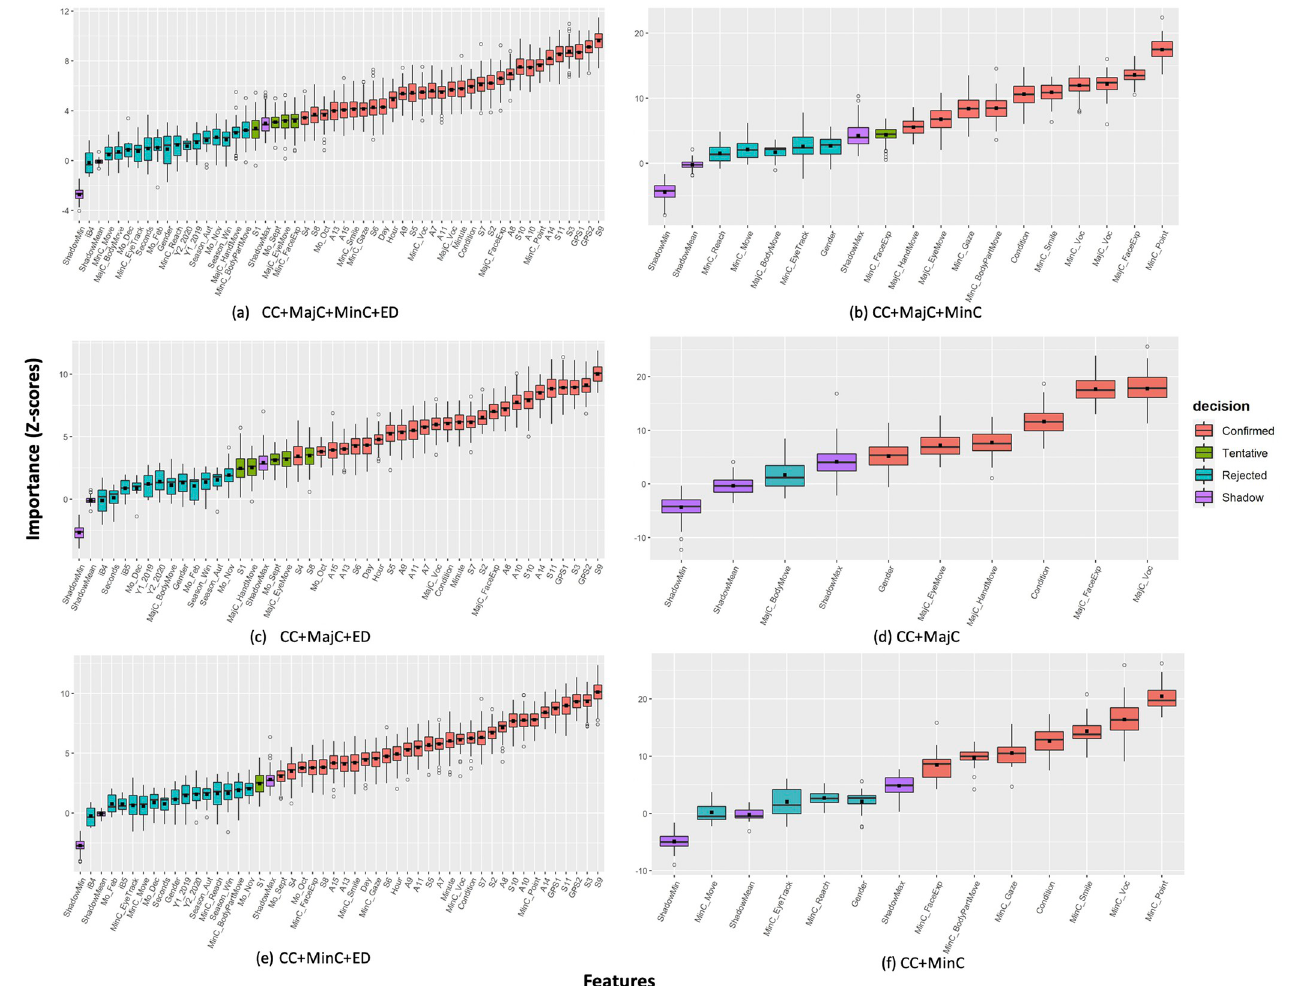
Fig 8. Variable importance ranking based on Boruta feature selection method in class 7. CC = child characteristics; MajC = major movement category; MinC = minor movement category; ED = environment data; Condition = PIMD or IDs; MinC_Gaze = gazing; MinC_ChangeLOS = changing line of sight; MinC_FaceExp = facial expression (other than smile); MinC_Voc = vocalization as minor category; MinC_Point = pointing; MinC_Reach = reaching; MinC_Move = moving; MinC_Appro = approaching; MinC_BodyPartMove = movement of a part of the body; MajC_EyeMove = eye movement; MajC_FaceExp = facial expressions; MajC_Voc = vocalization as major category; MajC_HandMove = hand movements; MajC_BodyMove = body movements; GPS1: Longitude; GPS2: Latitude; iB4 = classroom; iB5 = other iBeacon device; S1: Ultraviolet (UV) range (mW/cm2); S2, S3, S4: 6-axis (Accel+Geomag) sensor ranges [g]; S5, S6, S7: 6-axis (Accel+Geomag) sensor resolutions [ μ T]; S8: UV resolution [Lx]; S9: Pressure sensor range (hPa); S10: Temperature and humidity sensor range (˚C); S11: Temperature and humidity sensor resolution (%RH); A7: Minimum temperature (˚C); A8: Maximum temperature (˚C); A9: Atmospheric pressure (hPa); A10: Main temperature (˚C); A11: Humidity (%); A13: Cloudiness (%); A14: Wind direction (degrees); A15: Wind speed (meters/ second); Mo_Feb = February; Mo_Sept = September; Mo_Oct = October; Mo_Nov = November; Mo_Dec = December; ShadowMin = minimum Z-score of a shadow attribute; ShadowMax = minimum Z-score of a shadow attribute; ShadowMean = average Z-score of a shadow attribute.